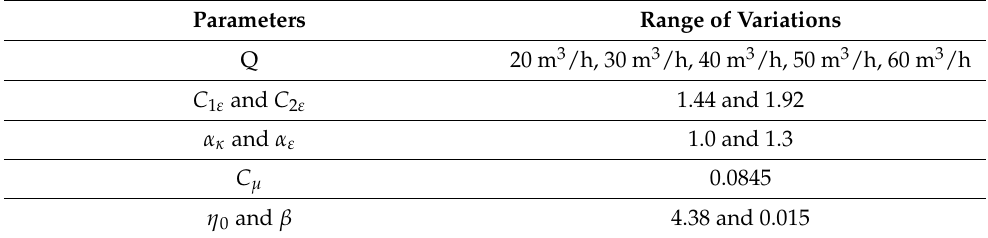
Table 1. Study parameters and their range of variations.